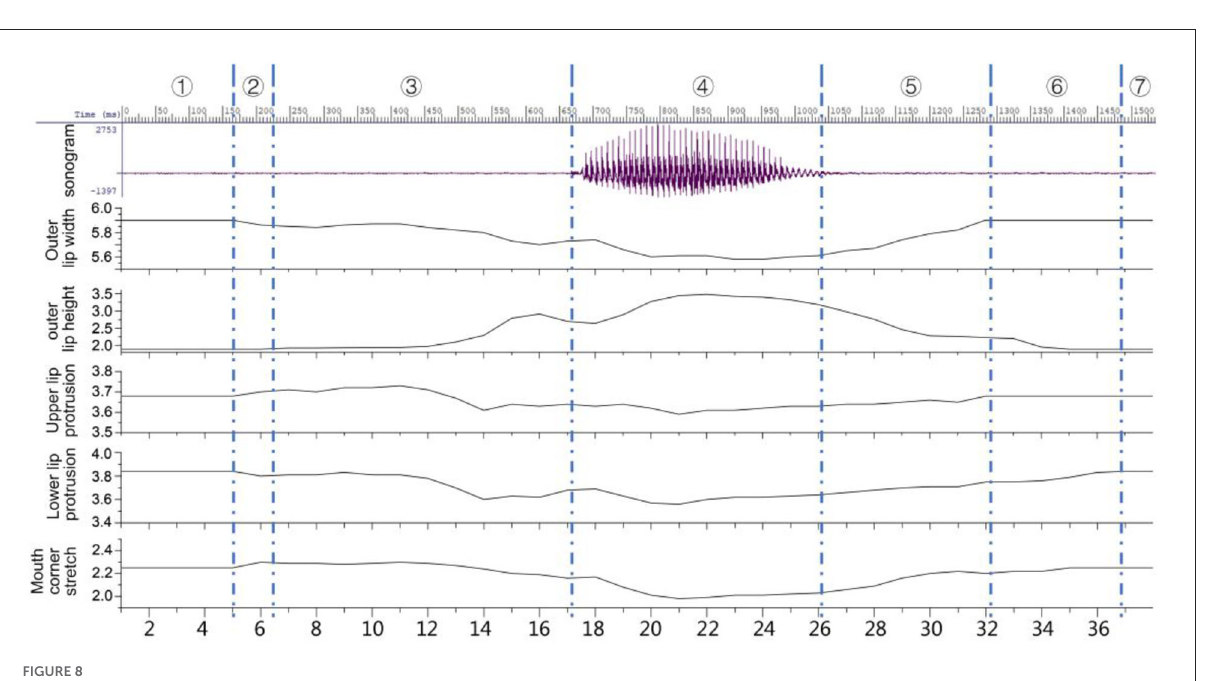
are: the outer lip width is 5.87 cm, the outer lip height is 1.9cm, the upper and lower lip protrusions are